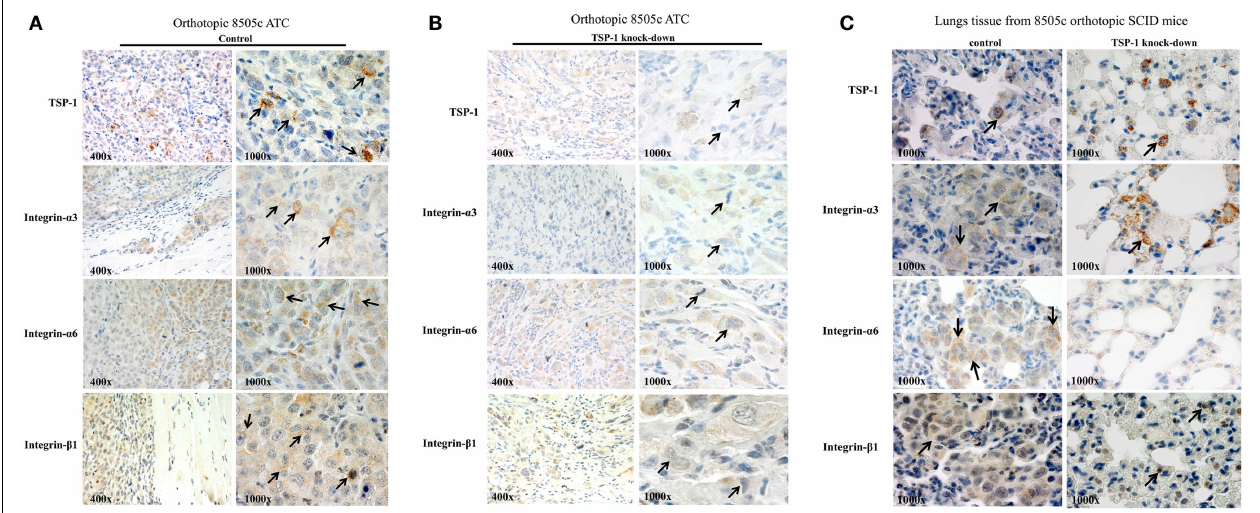
mice; arrows mark protein immunoexpression ofTSP-1, ITG α 3, ITG α 6, and ITG β 1 in the metastatic 8505c cells in the lungs tissue of control SCID mice. By contrast, IHC staining in theTSP-1 knock-down condition highlightsTSP-1, ITG α 3 and ITG β 1 protein expression in macrophages (noted by the dot-like, granular cytoplasmic staining, and bland histomorphology) but not in the metastatic 8505c cells which were absent; whereas, ITG α 6 protein immunoexpression is completely negative in theTSP-1 knock-down condition.